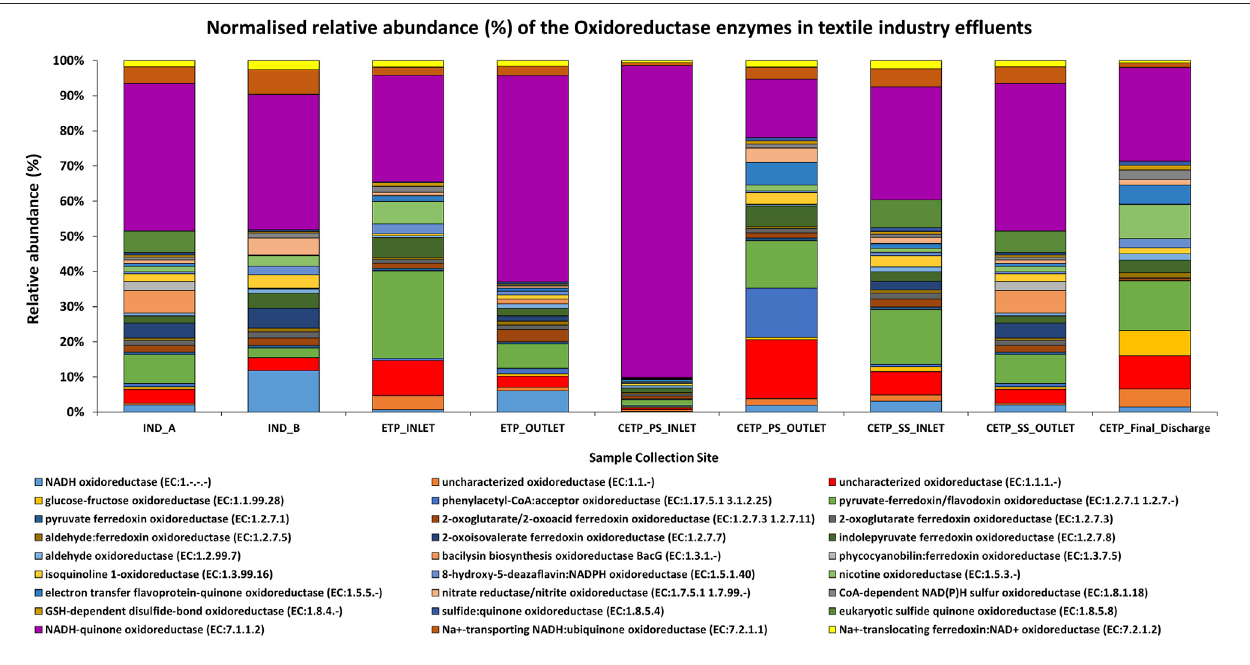
FIGURE 7 | Normalized relative abundance (%) of the key oxidoreductase enzymes found in different samples of the textile industry ef fl uent sites. The dominant enzymes identi fi ed in the industry ef fl uent sites (IND_A and IND_B) were NADH-quinone oxidoreductase, NADH oxidoreductase, and pyruvate-ferredoxin oxidoreductase enzymes. The dominant enzymes present in the ETP sites were NADH-quinone oxidoreductase and pyruvate-ferredoxin/ fl avodoxin oxidoreductase . Similarly, CETP sites were found with the dominance of NADH-quinone oxidoreductase and pyruvate-ferredoxin/ fl avodoxin oxidoreductase . The uncharacterized oxidoreductase, apart from the NADH-quinone oxidoreductase and pyruvate-ferredoxin/ fl avodoxin oxidoreductase, was dominant in the fi nal discharge samples .